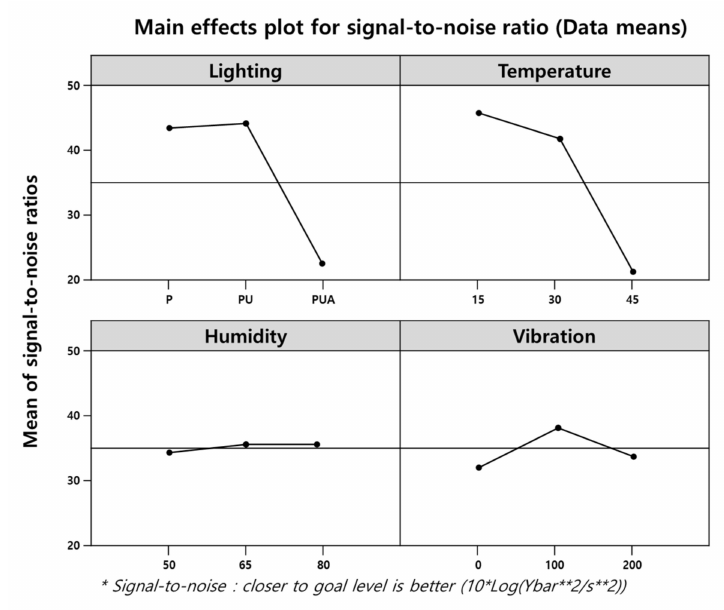
Figure 4. Analysis results of the main effects of the signal-to-noise